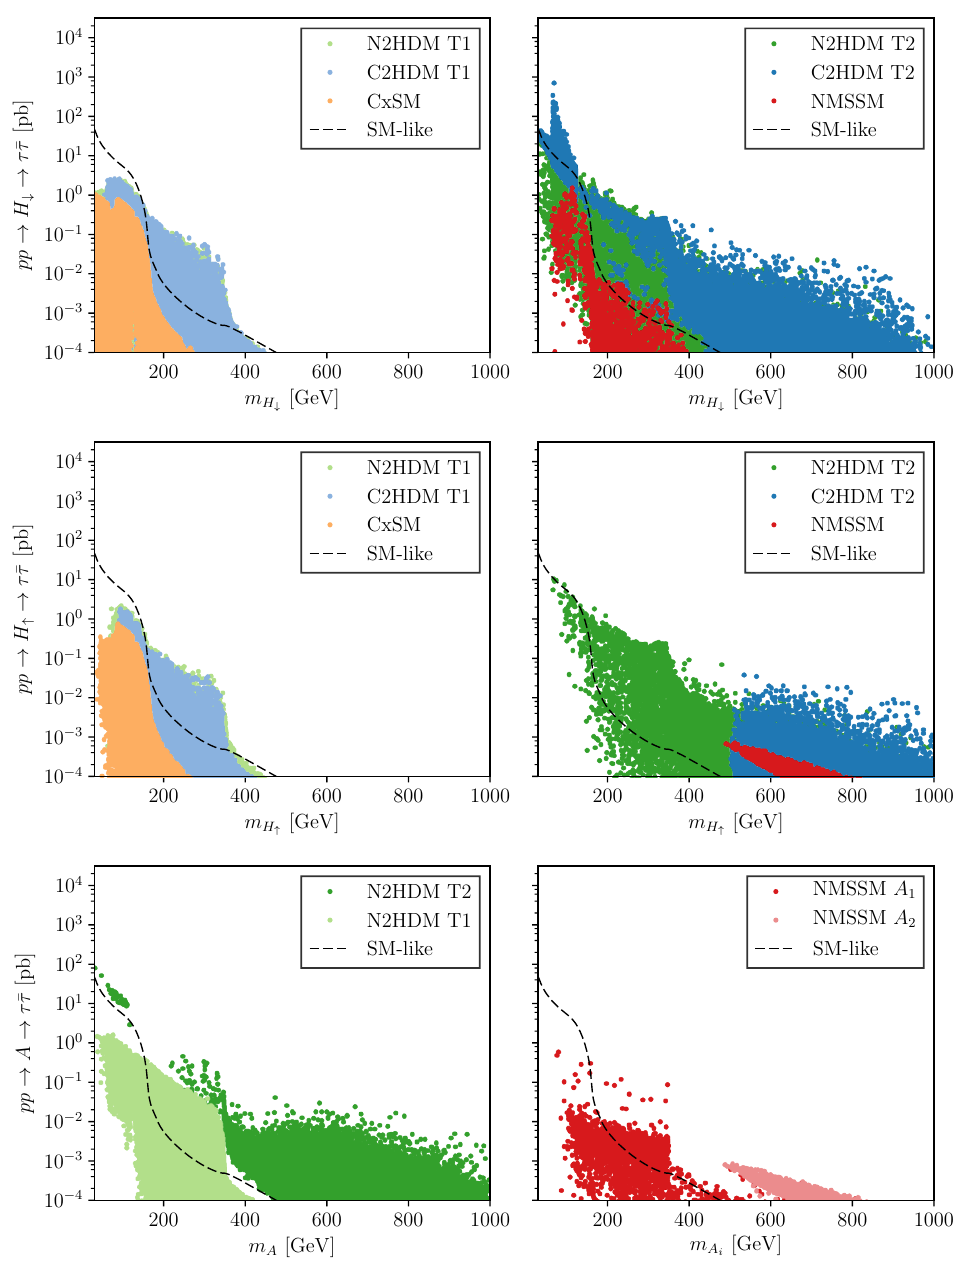
Figure 9 . Same as (cid:12)gure 8 but for the (cid:28) -pair (cid:12)nal state. Also included, in the lower row: tauonic decays of the N2HDM pseudoscalar A (left) for the types I (fair green) and II (dark green) and of the NMSSM pseudoscalars (right) A 1 (red) and A 2